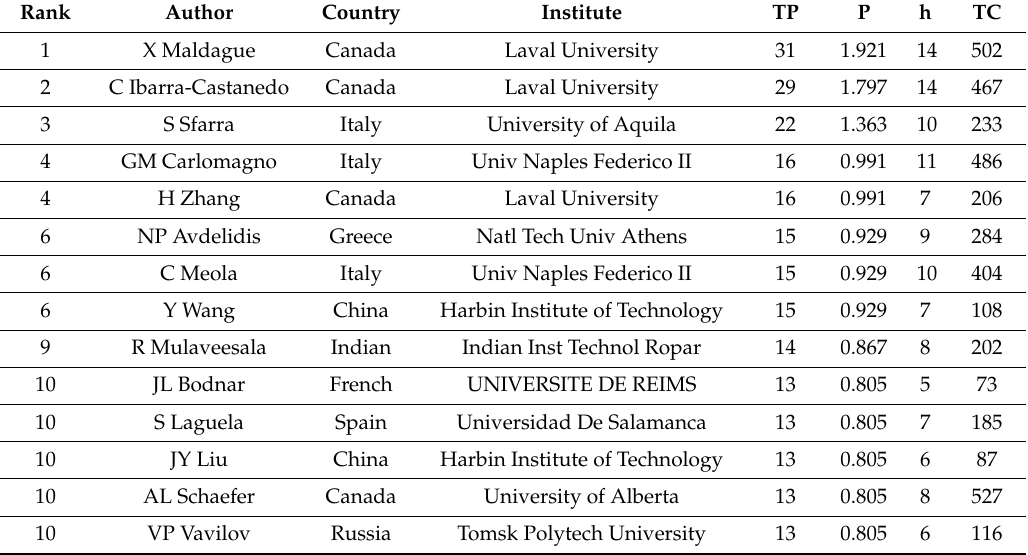
Table 6. Top 10 authors with the most